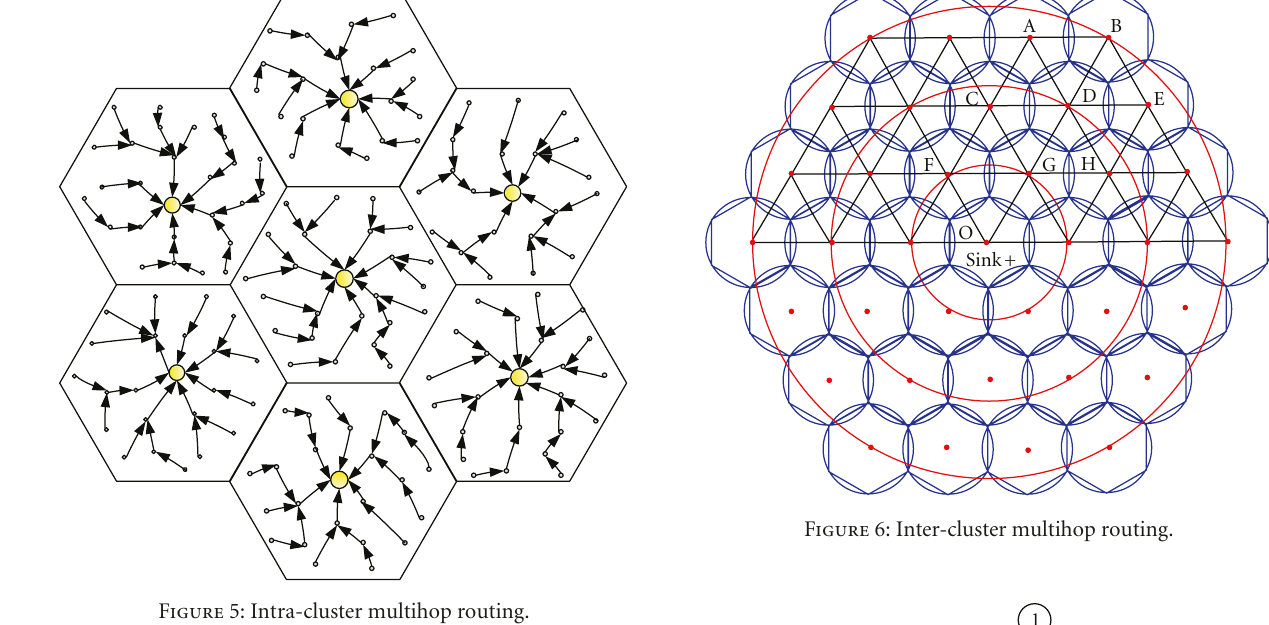
Figure 5: Intra-cluster multihop routing.